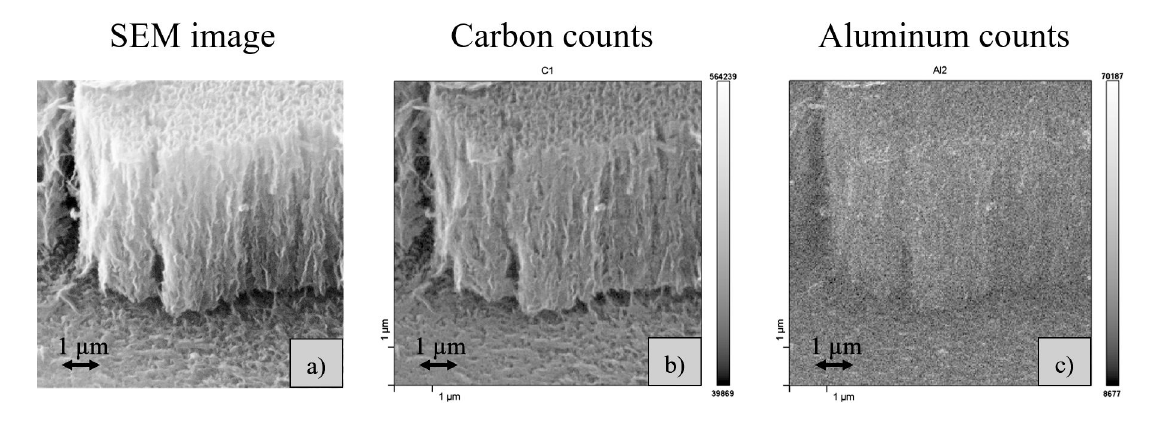
Figure 10: a) SEM image of the curled CNWs and corresponding b) carbon and c) aluminium mappings, as measured by Auger electron spectrosco- py.